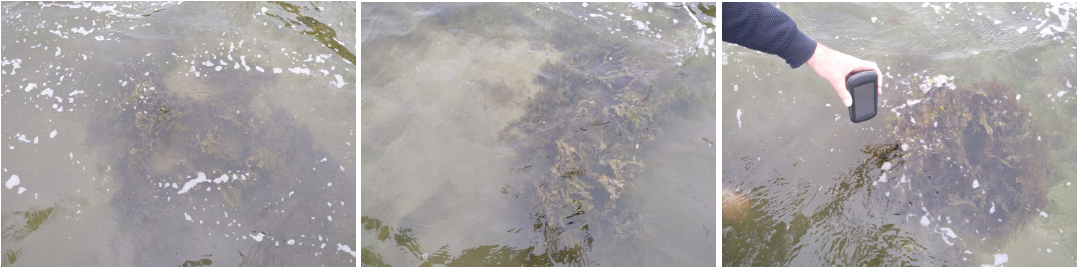
Figure 8. Photos of the boulders taken from above the water surface. Boulder 1, Boulder 2, Boulder